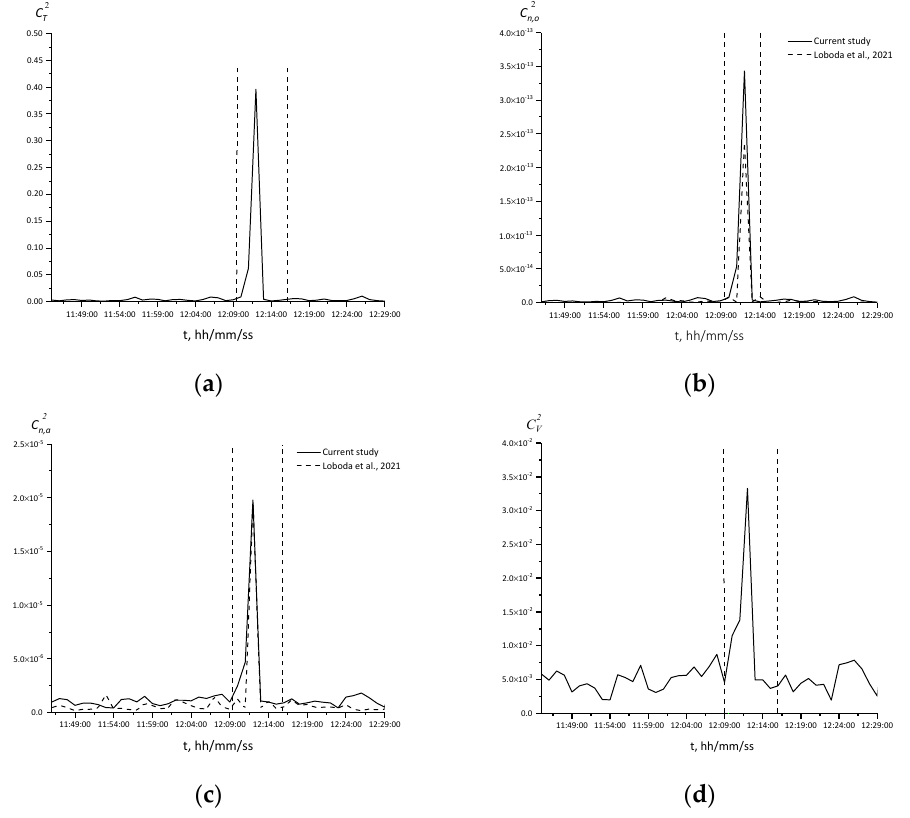
Figure 5. Change in the structural index of fluctuations in the refractive index of C 2 n , obtained by optical ( a ) and acoustic methods ( b ); structural index of fluctuations in wind speed ( c ) and temperature ( d